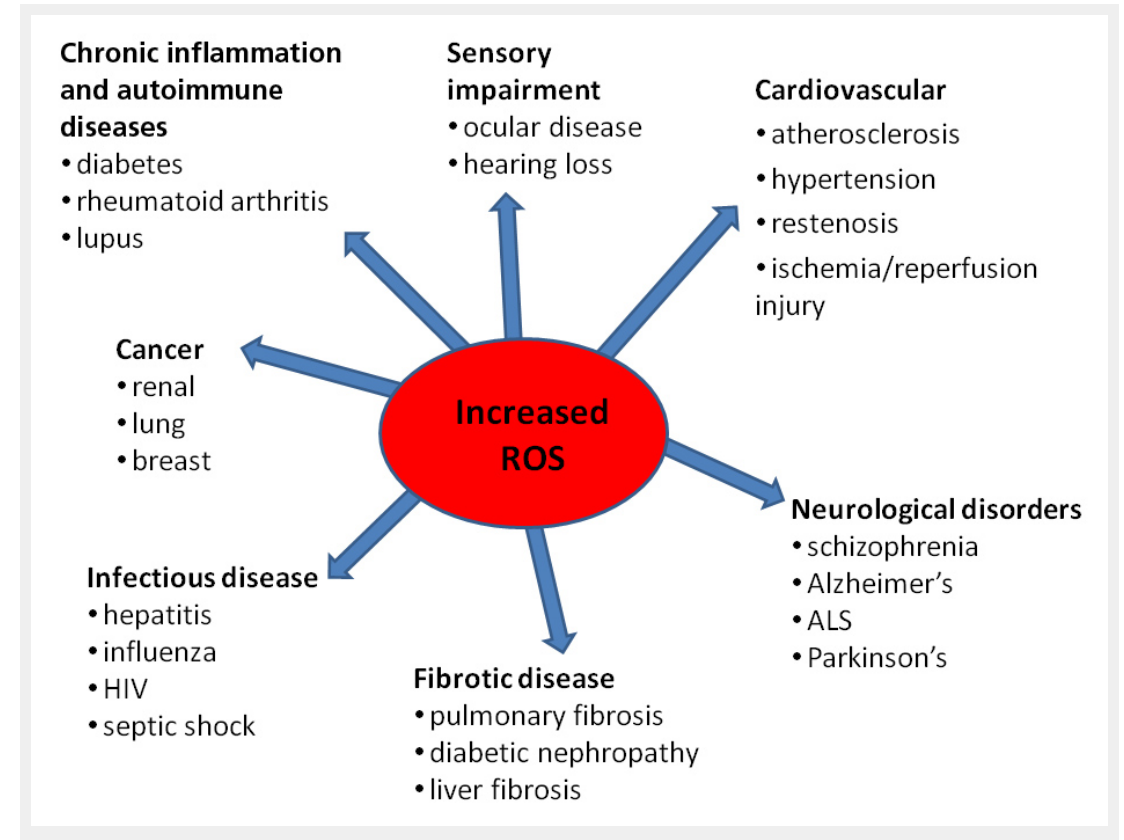
Figure 4 Overproduction of ROS and its contribution to various disease